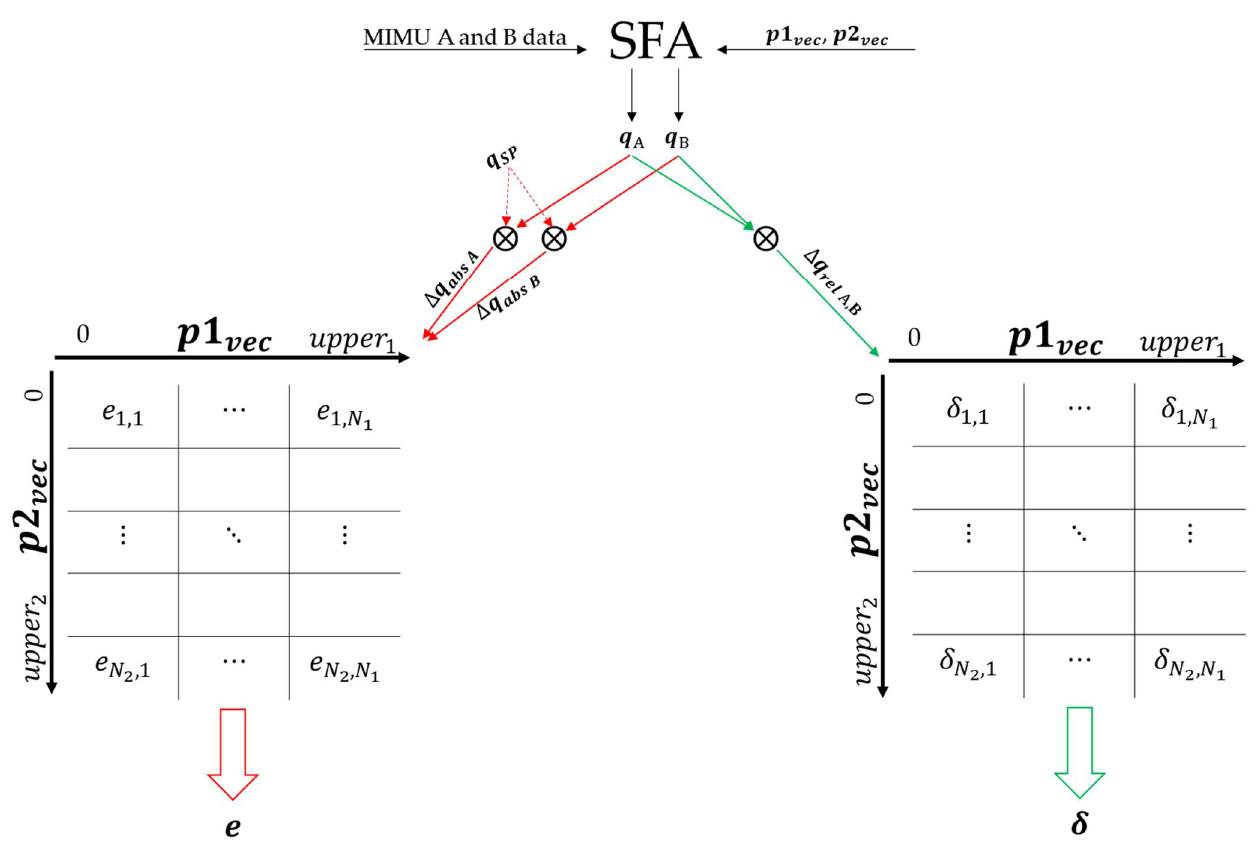
Figure 3. The grid-search approach followed to compute the absolute orientation error and the relative orientation difference for a given combination of the two parameter values. This process has been applied to each SFA for each of the nine experimental scenarios. Red and green arrows are related to the computation of the absolute error and relative difference, respectively.